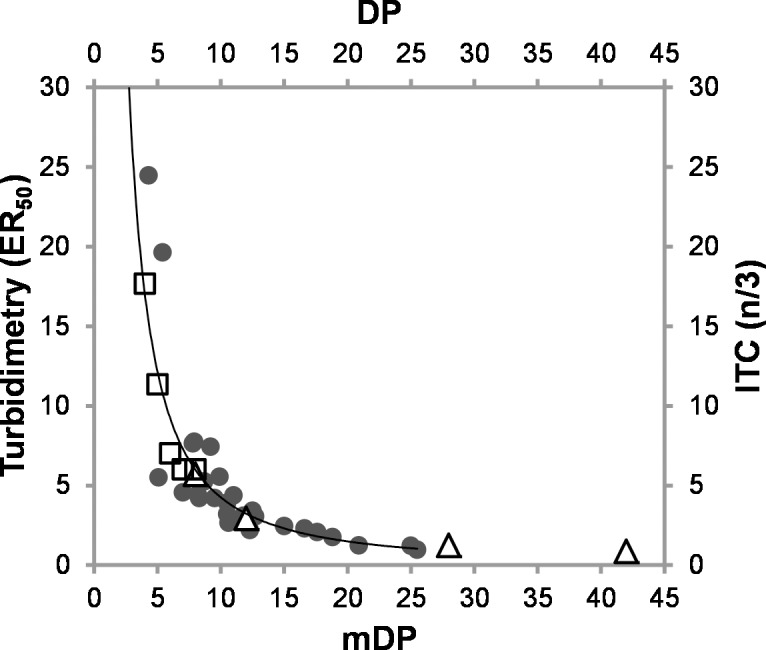
Turbidimetry data from the condensed tannin-BSA study overlaid with published isothermal titration calorimetry (ITC) results: ● –turbidimetry data fitted to a power function, Δ –ref. [19], and ϒ –ref. [22]; Note: the stoichiometric number (n) from ITC was divided by 3; ER50 –half maximal effective ratio; mDP–mean degree of polymerisation; DP–degree of polymerisation of oligomers.